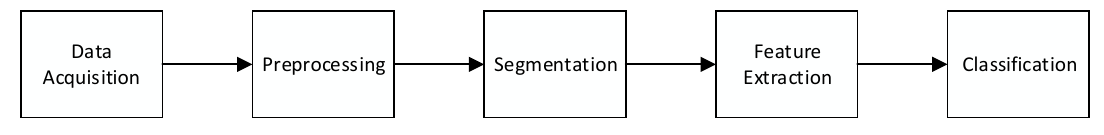
Figure 1. Activity recognition chain (ARC), according to